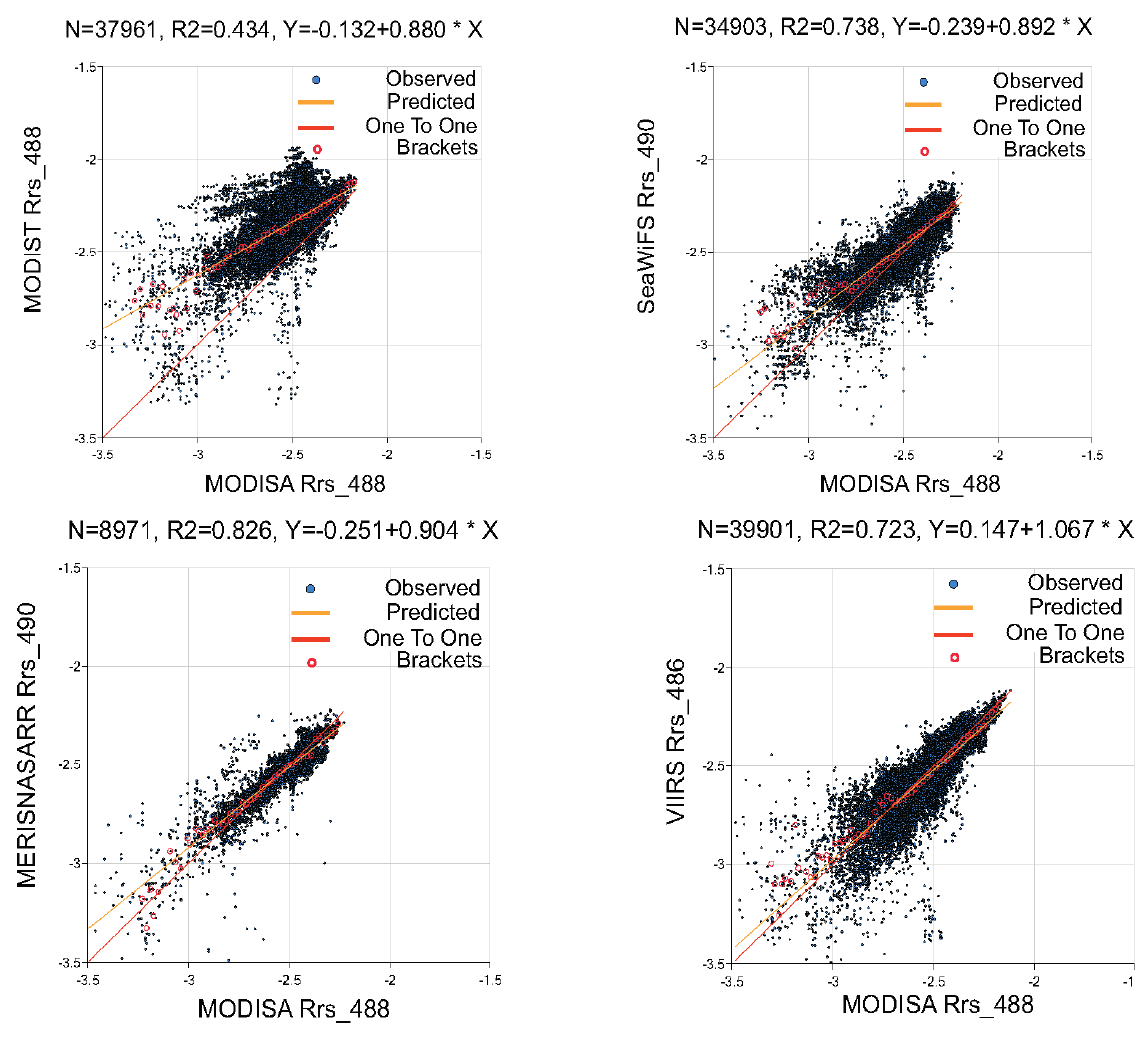
Figure 6. Inter-sensor comparison of log10-transformed remote sensing reflectance ( Rrs ) at approximately 490 nm (488 nm for MODISA and MODIST, 490 nm for MERIS, 486 nm for VIIRS). This band is typically used for high Chla in the OC3 algorithm. Dots show same-day match-ups between the sensor along the same transect (Figure 1) during the first 99 days in 2012 (2004 for SeaWiFS). Bracket points are the median values of the points’ corresponding medians of small brackets along the horizontal